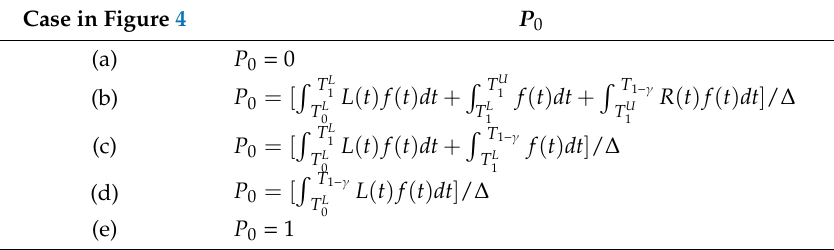
ff erent types of membership functions of (cid:101) T for the left-sided test. Figure 4. Five different types of membership functions of T Table 2. The possibility P 0 for left-sided Figure 4. Five different types of membership functions of T